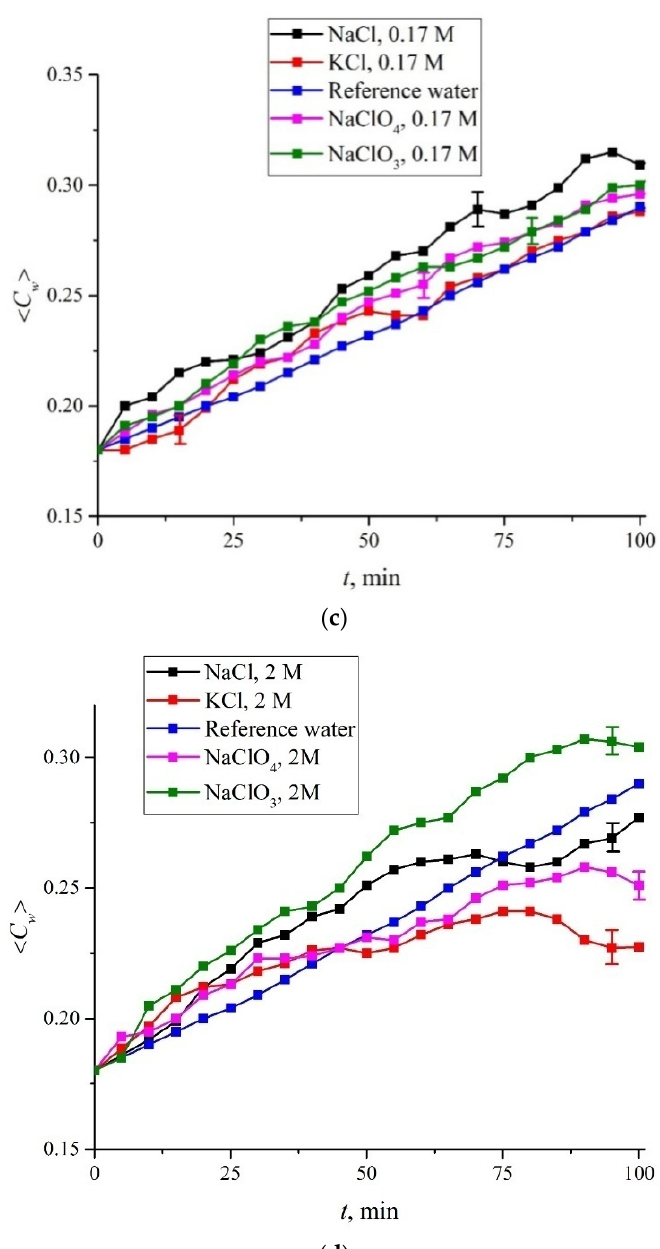
Figure 7. Dependence of the average concentration C w ( t ) for NaCl, KCl, NaClO 4 and NaClO 3 solu- tions; the dependence C w ( t ) for deionized (reference) water is also shown. The salt concentrations are the following: panel ( a )—10 − 3 M; panel ( b )—0.1 M; panel ( c )—1.07 M; panel ( d )—2 M.